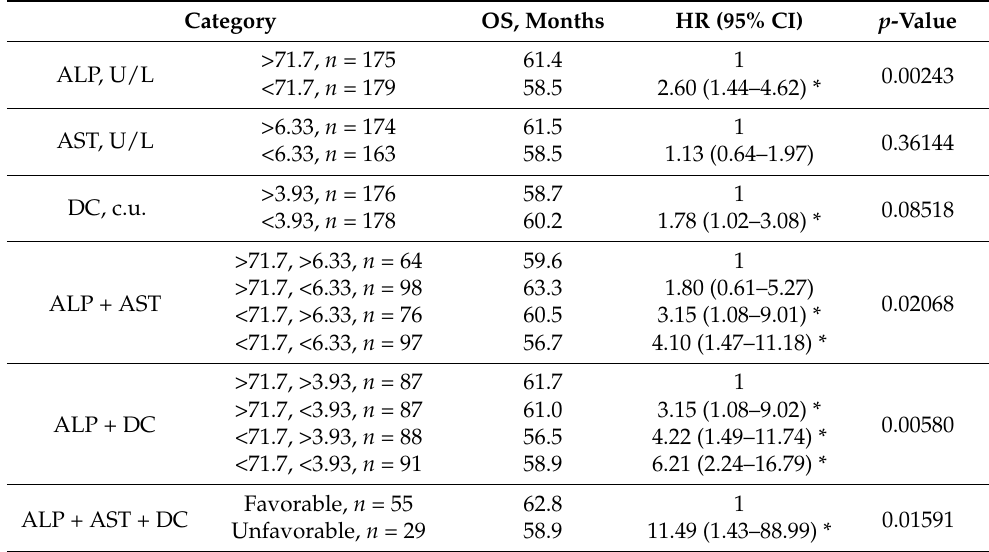
Table 3. Biochemical composition of the saliva of patients with breast cancer depends on the